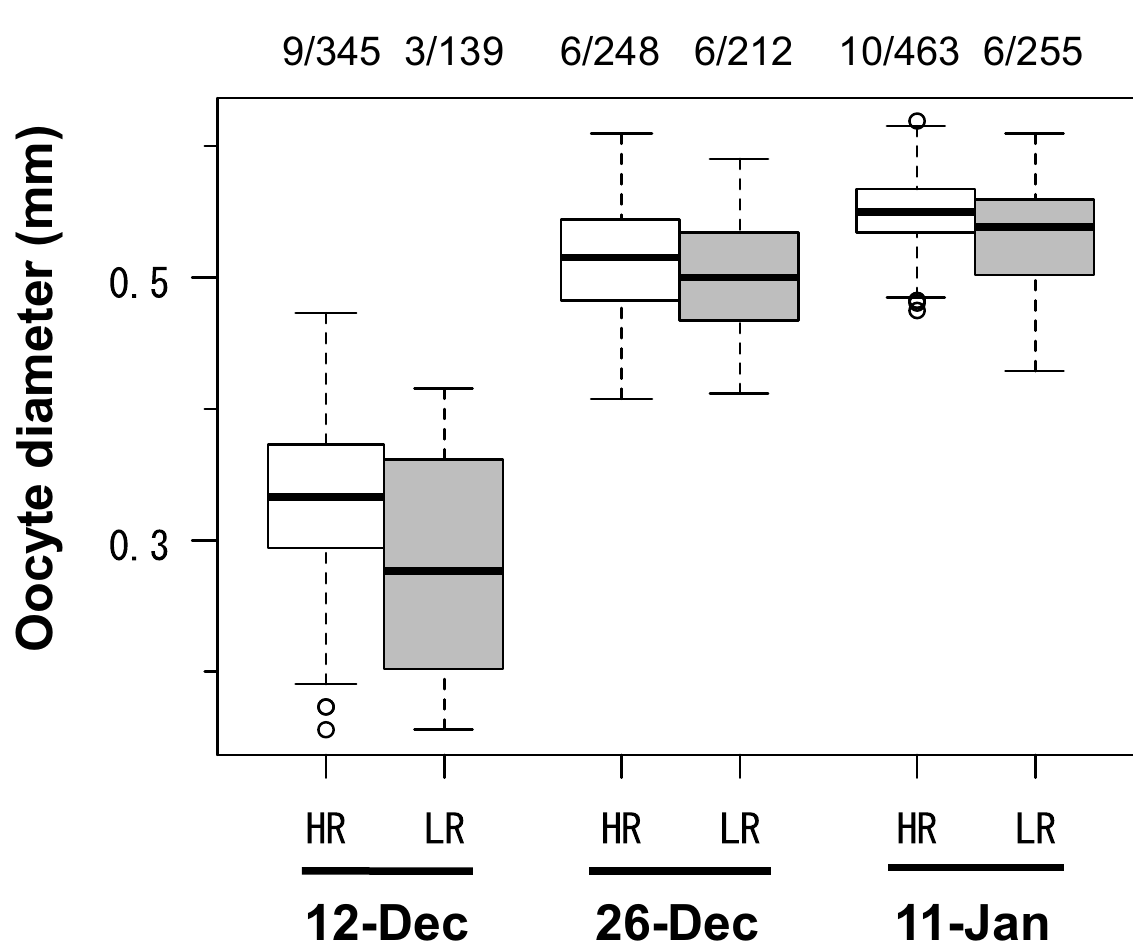
Fig 4. Boxplots of the oocyte diameter in western sand lance ( Ammodytes japonicus ) in Experiment II. Numerals indicate the number of individuals / the number of eggs measured. Significant differences between the high ration (HR) and low ration (LR) groups were detected (one-way nested ANOVA, p < 0.001 for all